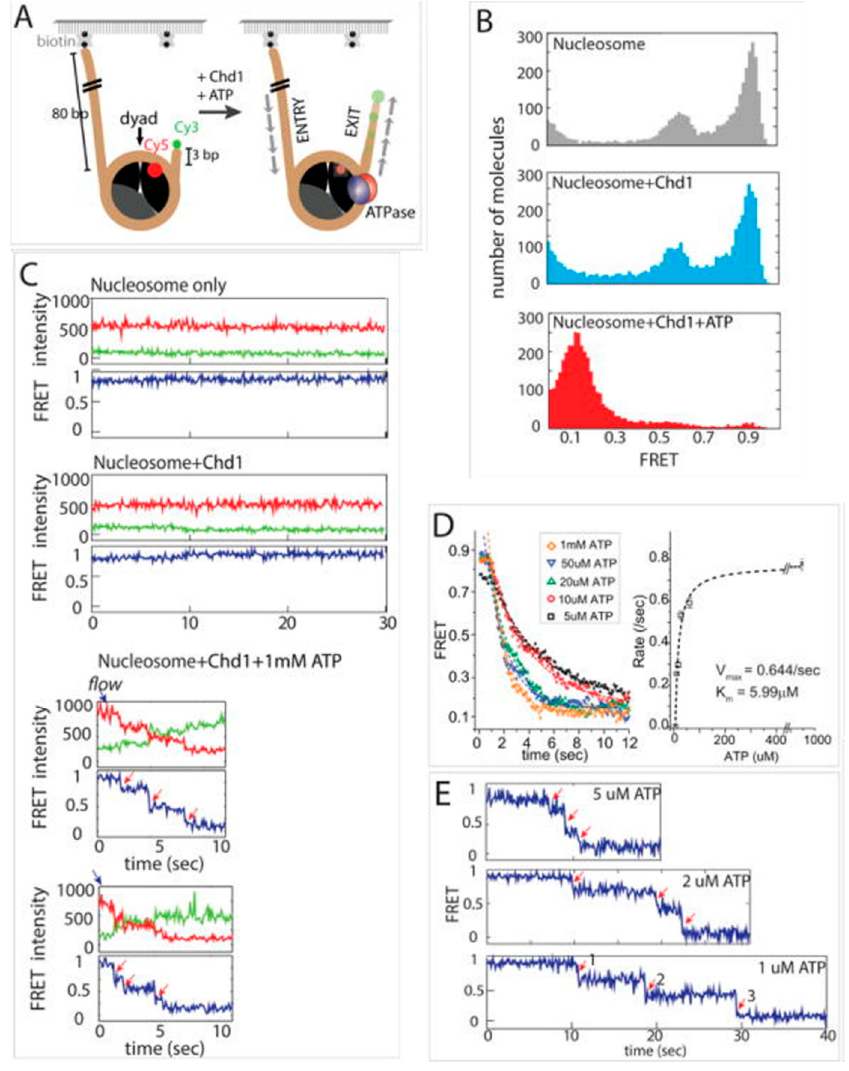
Figure 4. Interaction of Chd1 with nucleosome studied with smFRET. ( A ) The nucleosomal DNA is labeled with Cy3 on the exit side. There are two Cy5 molecules one on each histone H2A(T120C). In the figure, only the proximal Cy5 is shown. ( B ) The FRET efficiency histogram of the nucleosome (top), nucleosome after the addition of Chd1 without ATP (middle) and nucleosome after addition of Chd1 in the presence of ATP. In the absence of ATP, Chd1 does not influence the FRET efficiency histogram, whereas in the presence of ATP, almost the entire population of the nucleosome shows low FRET efficiency. ( C ) Representative smFRET traces for each condition mentioned in ( B ). In the presence of ATP, the stepwise depletion of the high FRET state. Green, red and blue denote donor emission, acceptor emission and FRET efficiency, respectively. ( D ) FRET efficiency as a function of time in the presence of different concentrations of ATP. Rates of ATP-dependent repositioning were calculated from these variations. These rates are then plotted against the ATP concentration and fitted with the Michaelis–Menten equation to calculate V max and K M . ( E ) smFRET traces at low ATP concentration to show the stepwise decrease in FRET efficiency clearly. Figure is adapted with per- mission from [66].